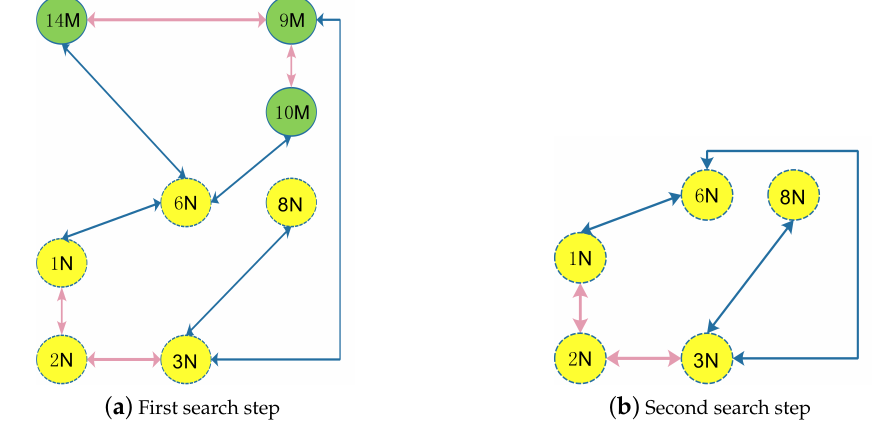
Figure 4. Absorption search for IEEE 14